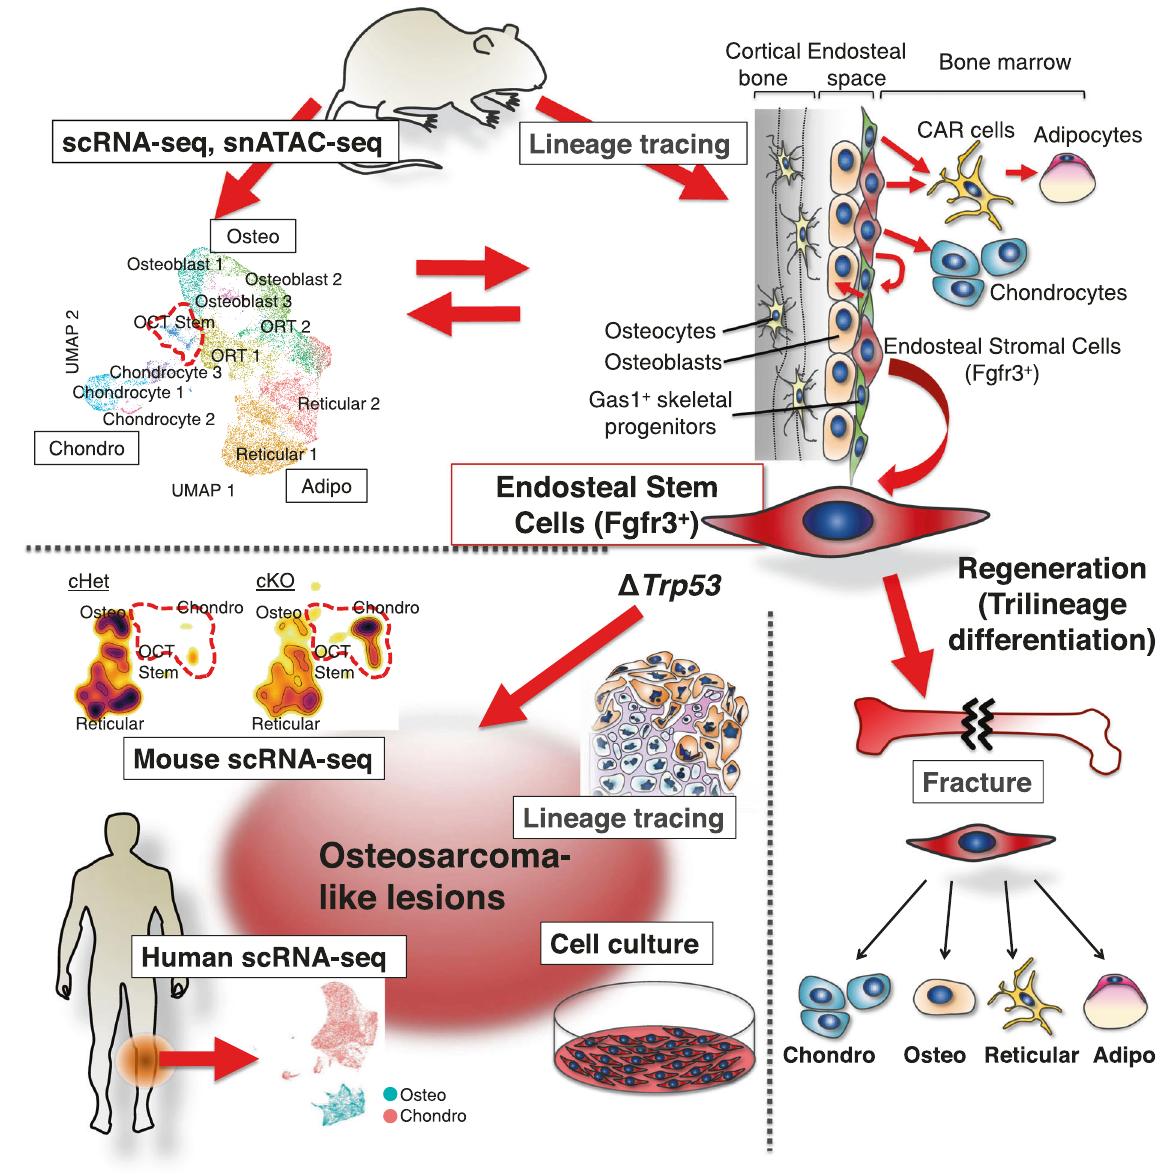
Fig. 10 | Location and function of Fgfr3-expressing endosteal stem/stromal cells. Fgfr3-expressing endosteal stem cells with osteoblast-chondrocyte transi- tional (OCT) identities in young bone marrow dictate active osteogenesis and aggressive tumorigenesis. The ambiguous state with epigenomic priming to